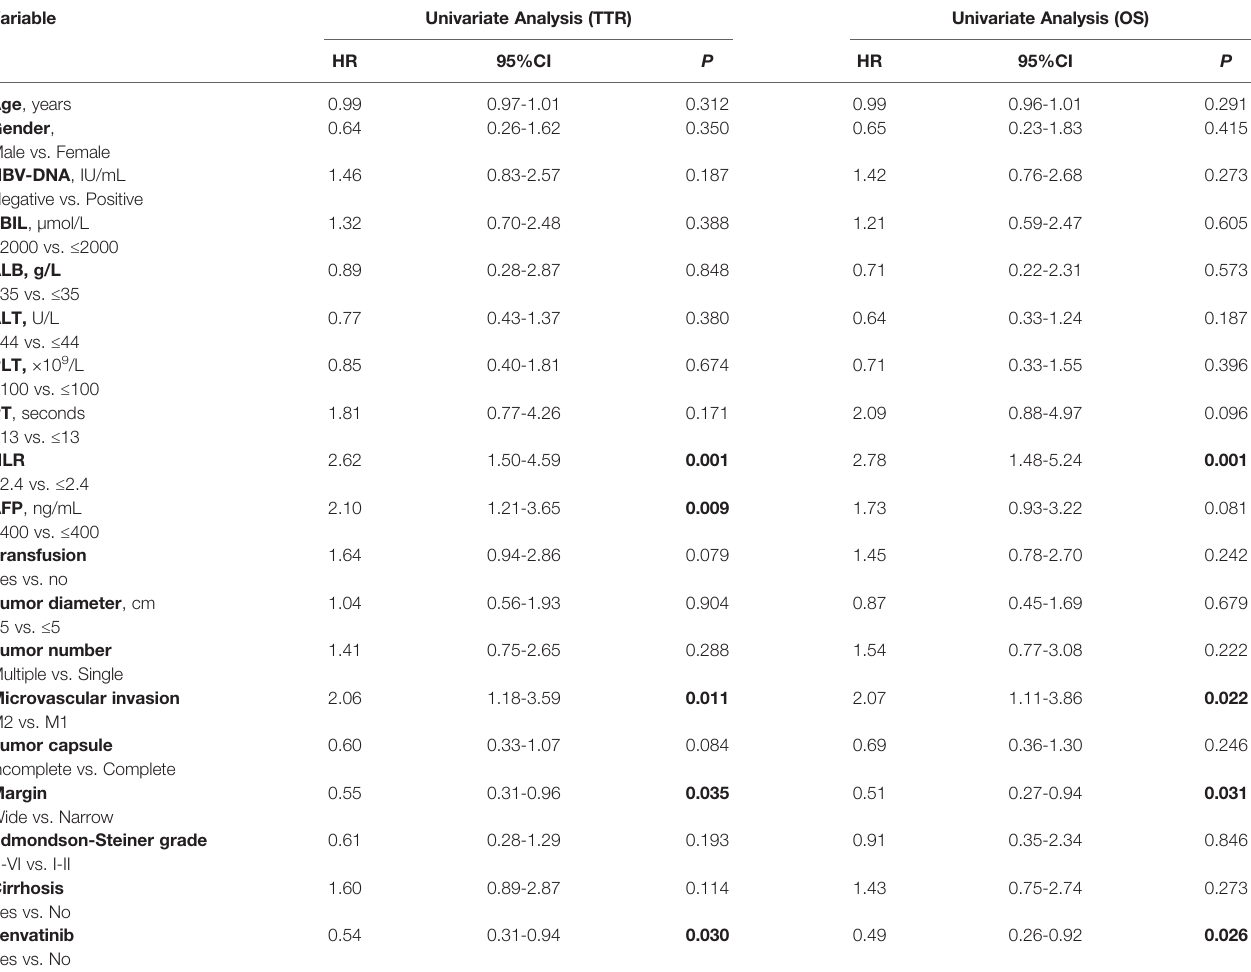
TABLE 6 | Univariate Cox-regression analysis for predicting TTR and OS in 114 HCC patients with Microvascular Invasion with and without adjuvant Lenvatinib after